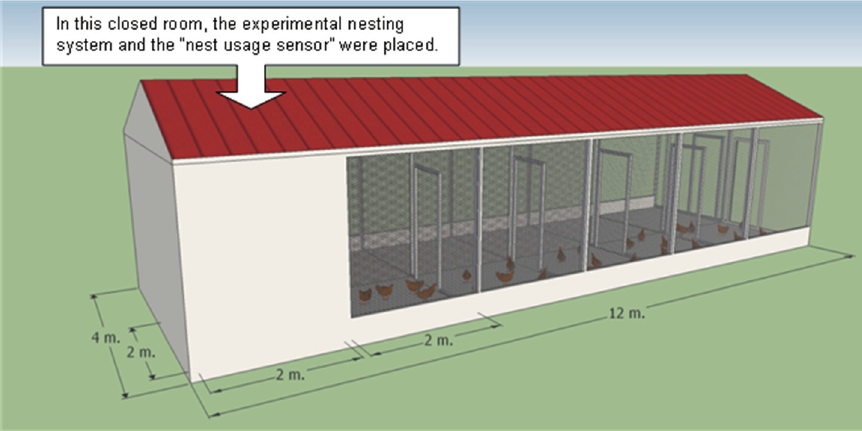
Figure 2. Drawing of the building where the experimental nesting system was installed.